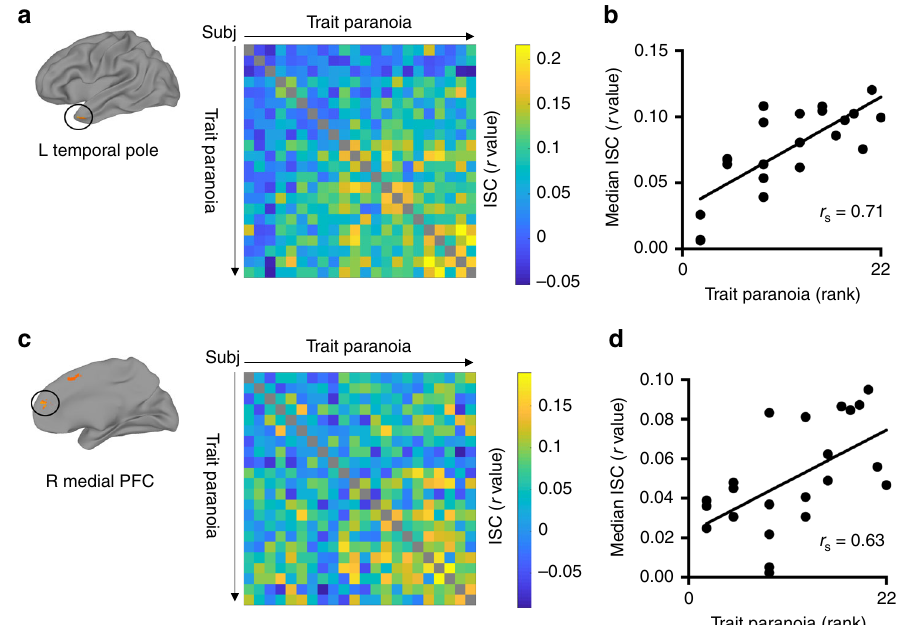
Fig. 4 Inter-subject correlation (ISC) scales continuously with trait paranoia. Post-hoc analyses for two regions of interest (ROIs) that emerged from the dichotomized contrast between high- and low-paranoia groups (cf. Fig. 3a): left temporal pole (top row) and right medial prefrontal cortex (PFC, bottom row). a Location of ROI (left) and participant-by-participant ISC matrix (right) for the left temporal pole. Participants are ordered by increasing trait paranoia score. Each matrix element re fl ects the correlation between two participants ’ activation time courses in the left temporal pole during narrative listening. Higher correlations are visible as one moves to the right and down along the diagonal, representing pairs of increasingly high-paranoia individuals. b Scatter plot of paranoia rank vs. median ISC value — i.e., the median of each row of the ISC matrix in a . Each dot represents a participant. Rank correlation indicates a signi fi cant monotonic relationship between trait paranoia and median ISC in left temporal pole ( r s = 0.71, p = 0.0002). c Location of ROI and participant-by-participant ISC matrix for the right medial PFC. Participants are ordered as in a . d Scatter plot of each participant ’ s paranoia rank vs. their median ISC value in the right medial PFC. As in b , rank correlation indicates a signi fi cant monotonic relationship between paranoia rank and median ISC ( r s = 0.63, p = 0.0016)